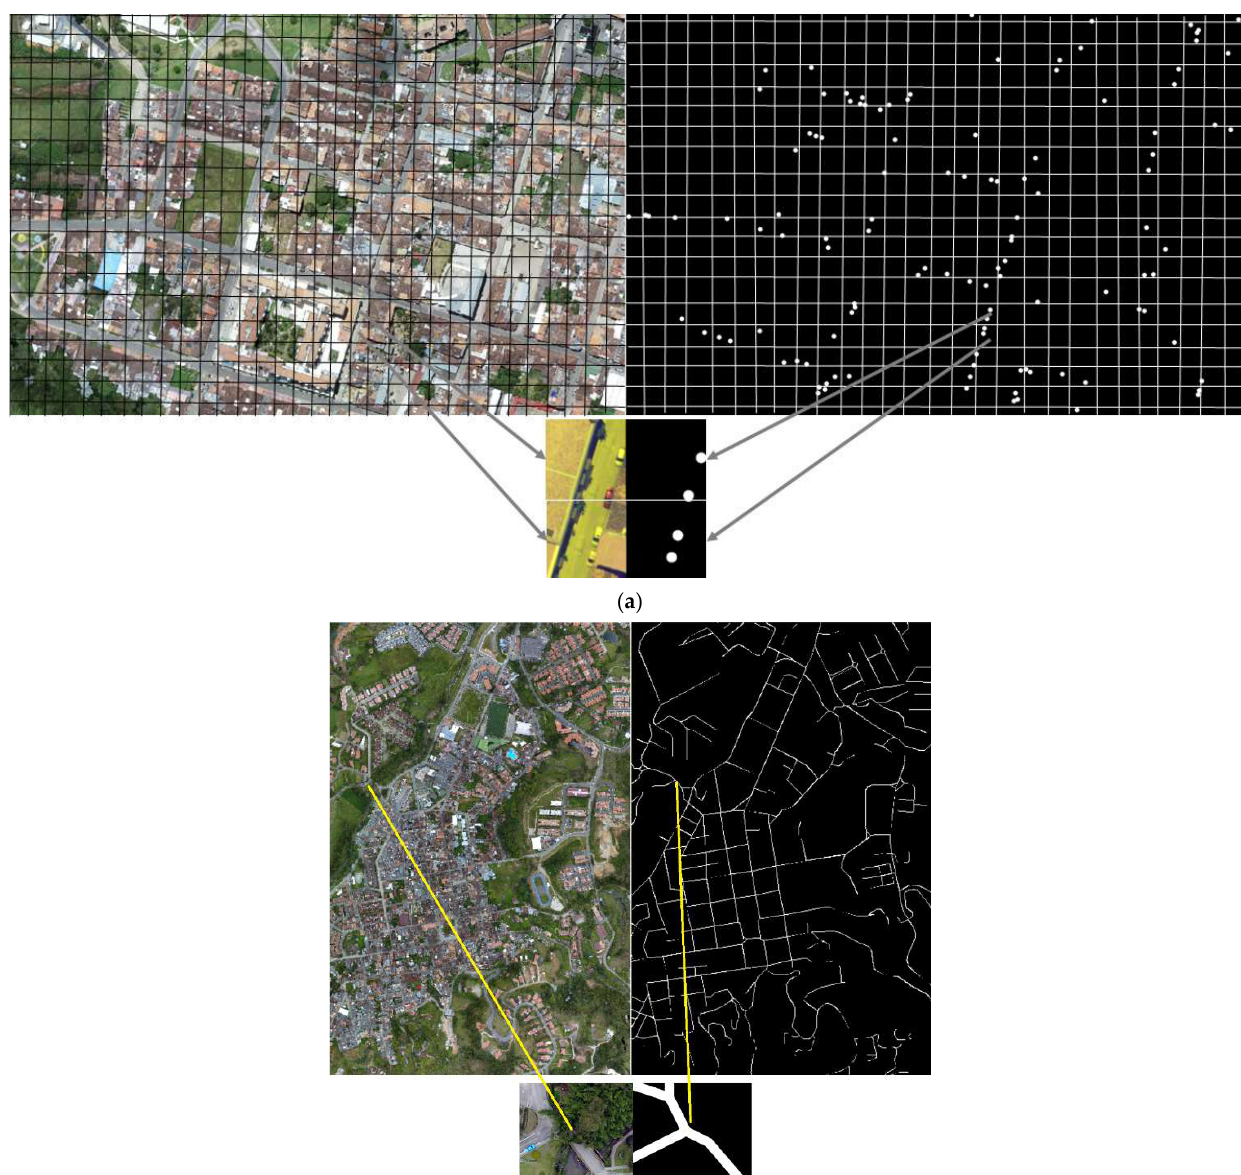
Figure 9. Produced datasets. ( a ) Vehicle dataset, ( b ) road dataset.